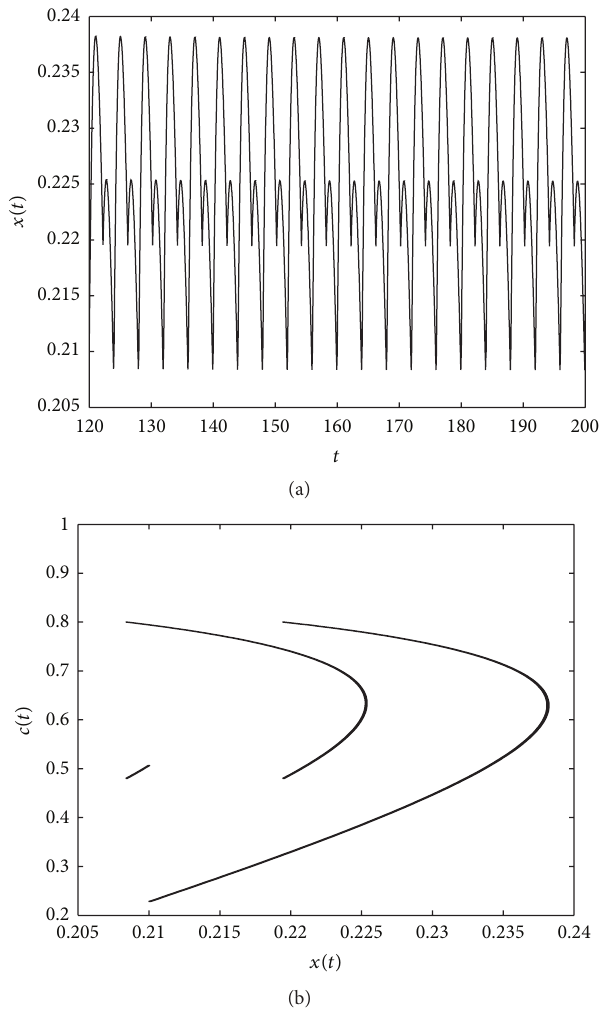
Figure 2: Dynamics of a hybrid impulsive model with parameters = 0.7 ; 𝜇 = 0.8 ; ℎ = 0.9 ; 𝑇 = 4 ; 𝛽 𝑟 = 0.5 ; 𝐾 = 2 ; 𝑟 1 ET = 0.8 ; 𝑥(0) = 0.6 ; 𝑐(0) = 0.5 . (a) Time series of the species 𝑥(𝑡) . (b) Phase